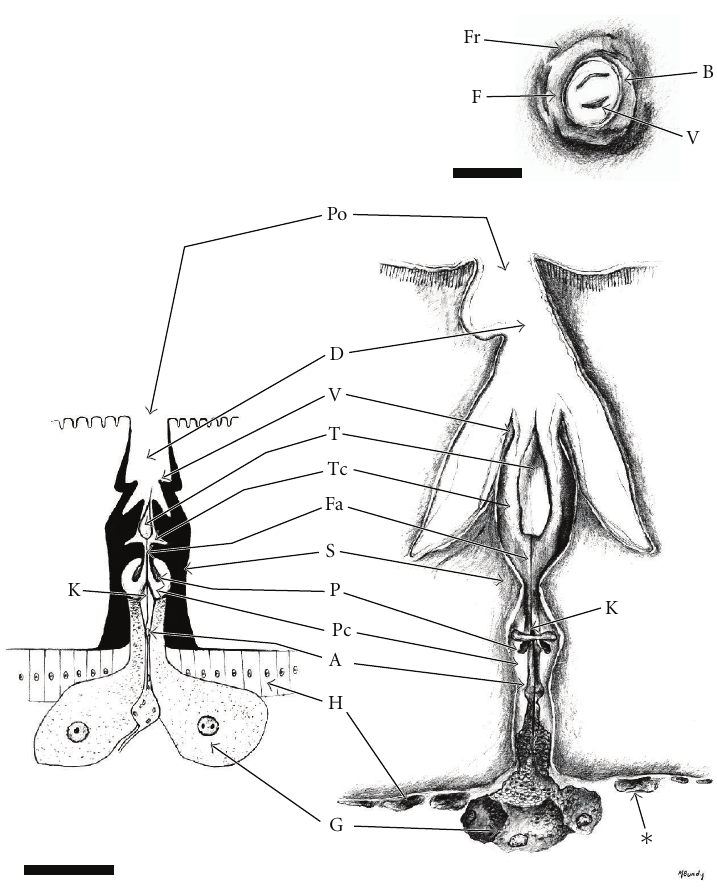
Figure 1: Representative drawings of the large wax glands (sensilla sagittiformia = arrow-organs) in nonfed adult females of R. sanguineus . Top: direct view looking down on the pore opening of the gland. Bar = 10 µ m. This transverse view of the gland opening shows the fringe (Fr), the spongy elastic chitinous frame (F), the border of the pore opening (B), and the top of the valvular arm (V), that make up the roof of the tuft chamber. Bottom left: redrawing of the original 1942 description of the sensillum sagittiforme in sagittal view from Hyalomma marginatum Koch by Schulze [2] (also redrawn in Dinnik and Zumpt [1]). Bottom right: drawing of the large wax gland from the present study (redrawn from Figure 2(a)). Labeled structures: pore opening of gland (Po), distal arrow-shaped duct (D), valvular arm of the roof of the tuft chamber (V), tuft (T), tuft chamber (Tc), anchoring filament of the tuft (Fa), knot of the scolopale (K), spongy elastic chitin (S), projecting edges of the scolopale (P), proximal terminal chamber (Pc), axial sensory nerve fiber (A), hypodermis (H), glandular cells (G), and enlarged juxtapositioned transdi ff erentiating epithelial cells ( ∗ ). Bar = 30 µ